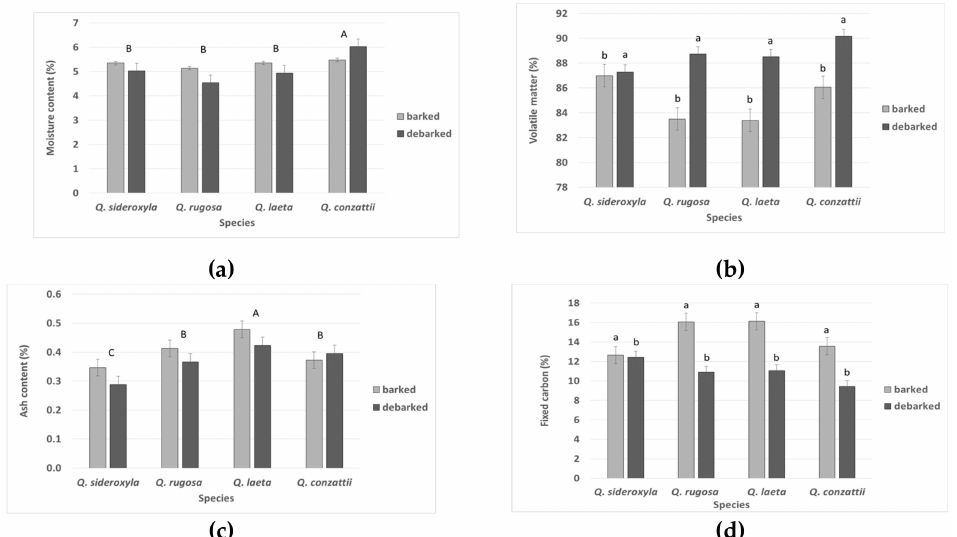
Figure 3. ( a) Moisture content; ( b ) Volatile matter; ( c ) Ash content; ( d ) Fixed carbon of four barked and debarked oak species (bars with di ff erent letters correspond to statistical significant di ff erences; p <